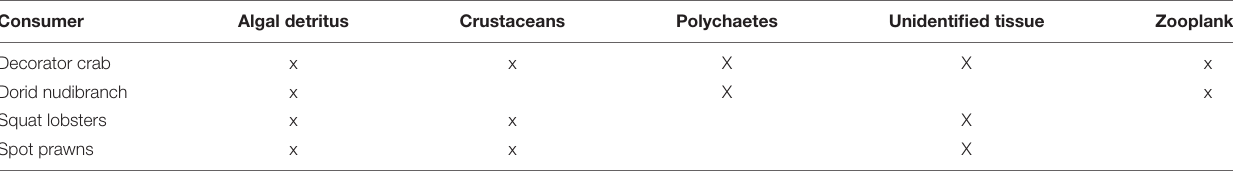
TABLE 2 | Food items other than sponge spicules found in consumer stomachs.